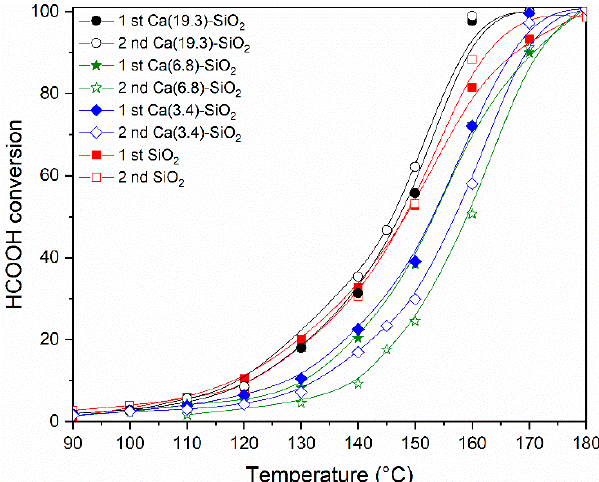
Figure 7. Catalytic activity of Ni solids after reduction at 400 °C at different reaction temperatures. The HCOOH conversions are plotted as function of the reaction temperature (W/F = 5 × 10 − 5 g·h·mL − 1 ; feed composition: 6% HCOOH/N 2 ).